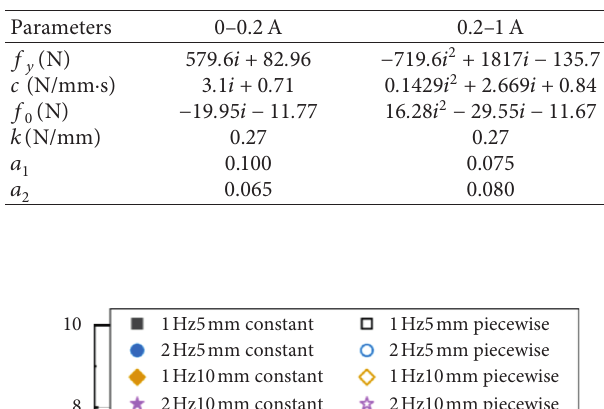
Table 3: Parameter identification results in piecewise fitting way.